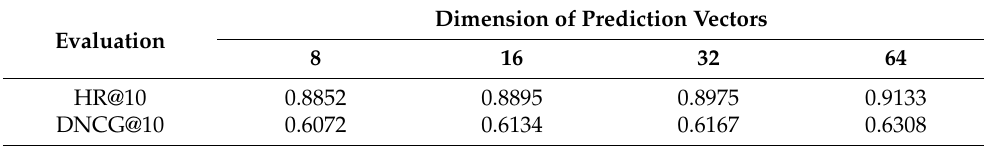
Table 4. The impact of different dimensions of prediction vectors on lastfm.